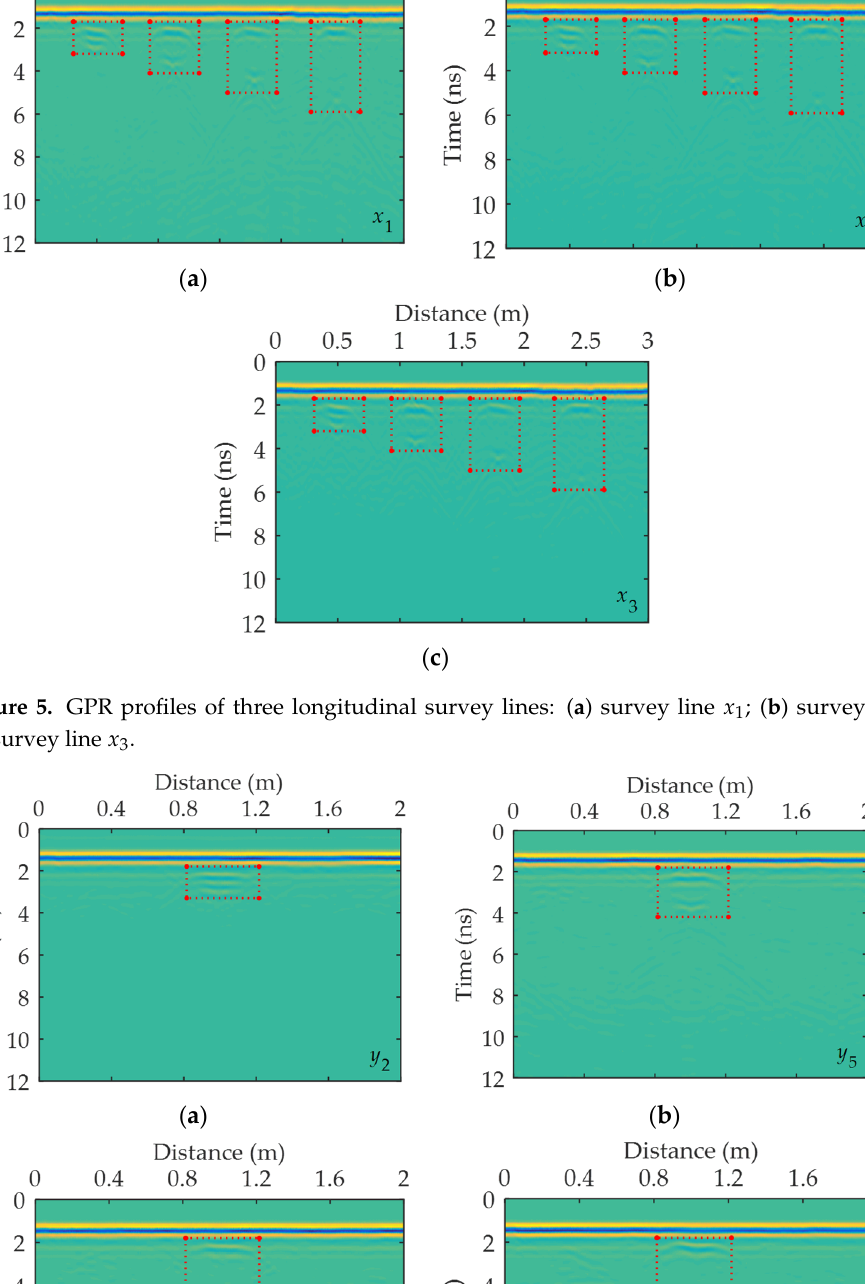
Figure 6. GPR profiles of four horizontal survey lines: ( a ) survey line y 2 ; ( b ) survey line y 5 ; ( c ) survey line y 8 ; ( d ) survey line y 11 ;